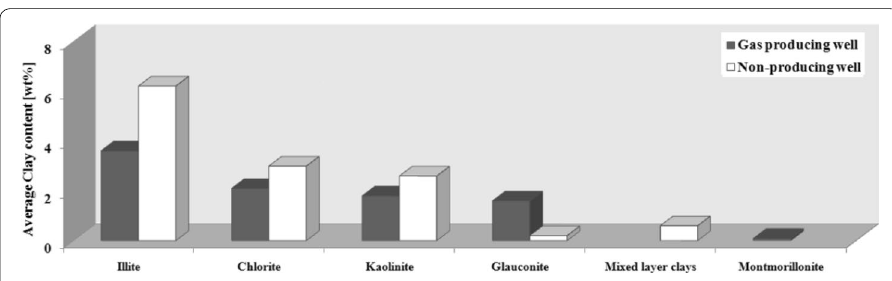
Fig. 3 The quantitative clay mineralogy of the Shurijeh Formation from the XRD